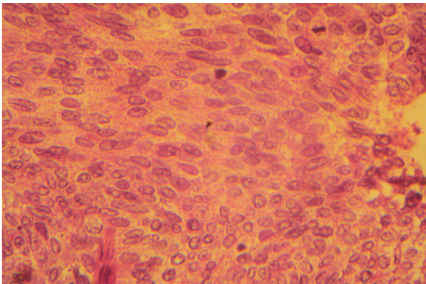
Figure3:Stainingoftumorcellswithantibodytocarcinoembryonic antigen confirming their eccrine differentiation (original magnifica- tion ×